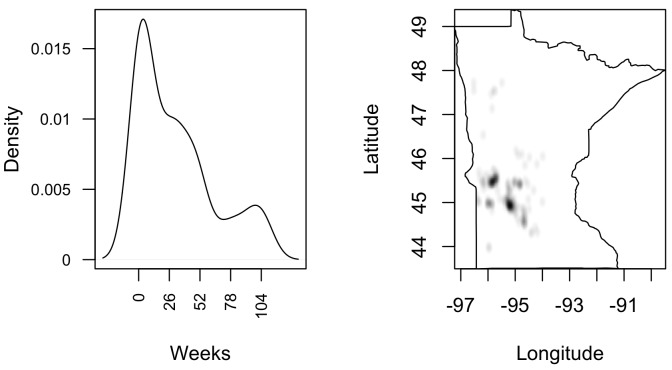
Temporal (left) and spatial (right) density of PRRS incident cases from July 2012 to June 2014 in the RCP-N212.